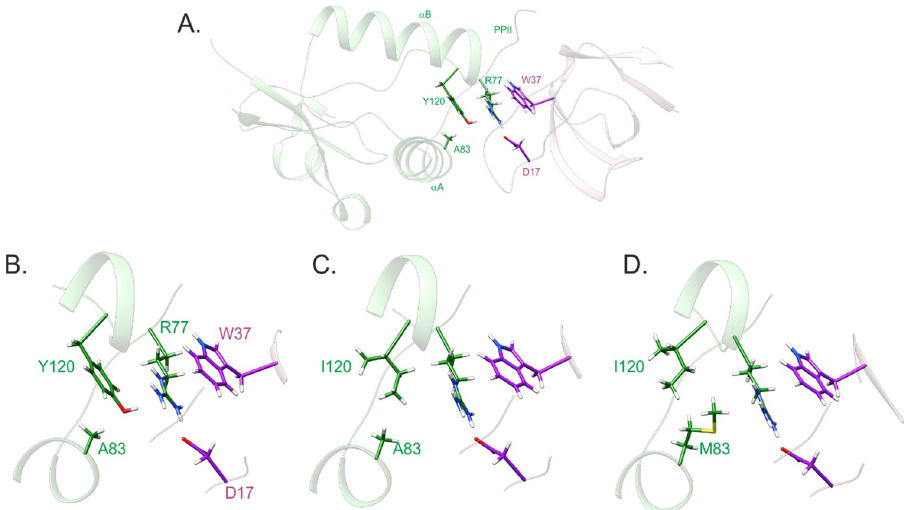
Fig 3. The arginine clamp. (A) Structure of the HIV-1 Nef (green)–SH3 (pink) complex (PDB ID 1EFN) highlighting critical residues in the interaction interface. (B) Close up view of the R clamp, stabilized by stacked Y-R-W side chains and a salt bridge between R77 (Nef) and D17 (SH3) side chains. (C) In the Y120I structure, one side of the R77 guanidinium plane is lacking non-bonded interactions. (D) In the A83M/Y120I, structure the long methionine side chain re-establishes non-bonded contacts for R77. The presented mutated complex structures were created by replacing Y120 or Y120 and A83 in UCSF Chimera [45] and minimizing the structures with AMBER [46].